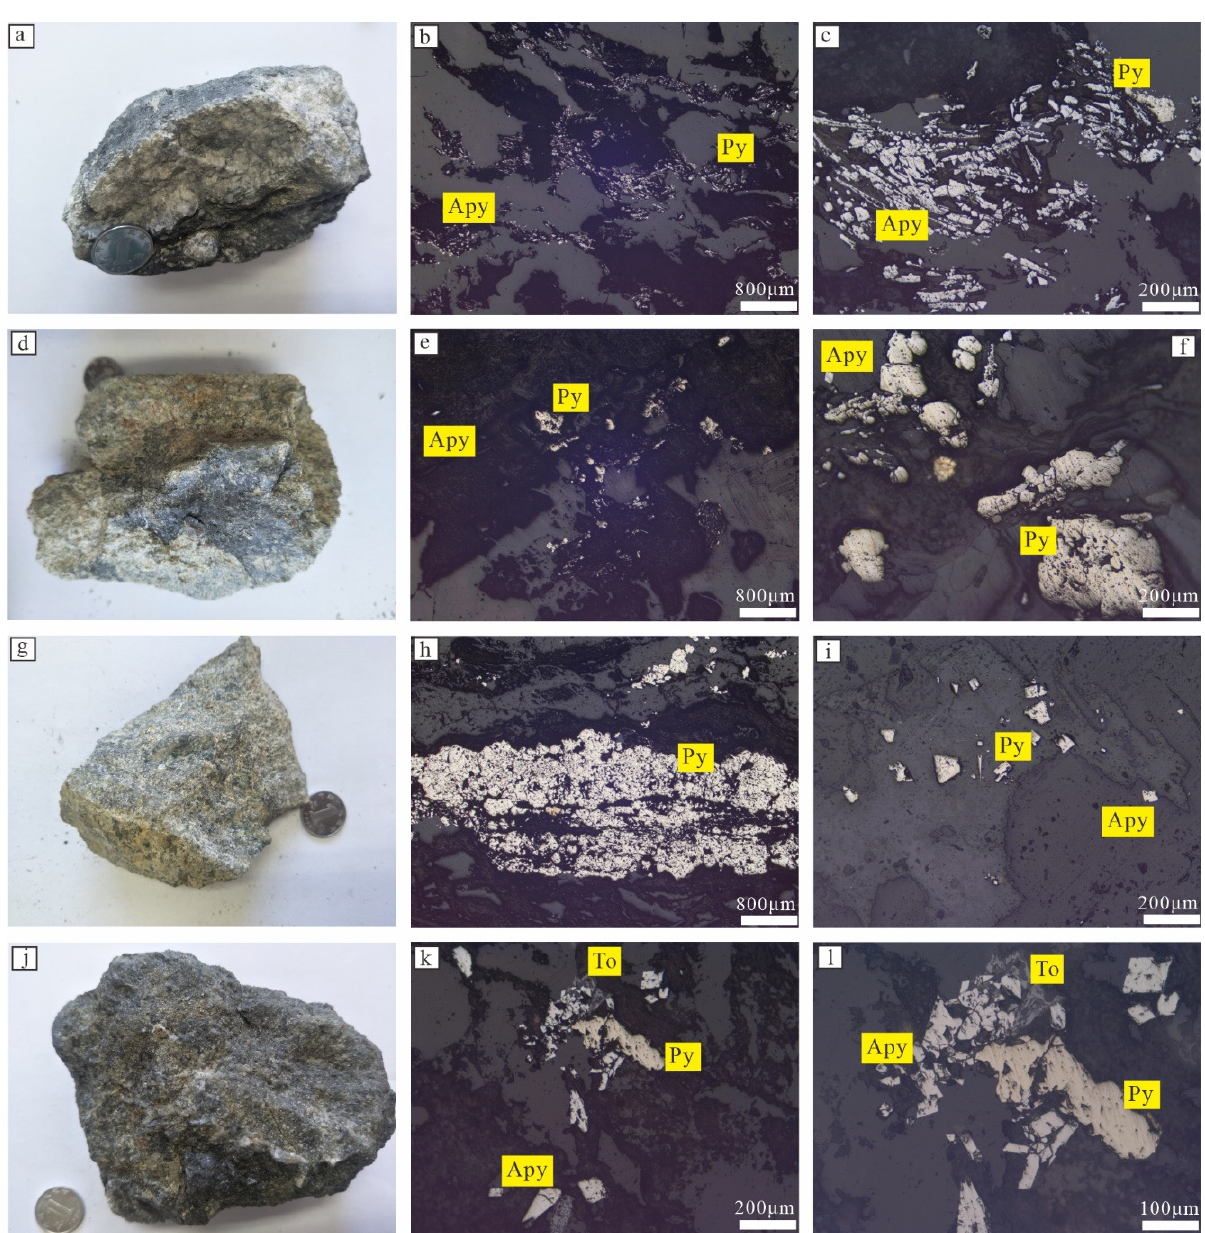
Figure 6. Hand specimens and photomicrographs of ores from various elevations in the Yanjingou Au deposit. a-c: ore samples of 3384 m; d-f: ore samples of 3340m; g-i: ore samples of 3284m; j-l: ore samples of 3090m. Py = pyrite; Apy = arsenopyrite; To = titanium oxide.